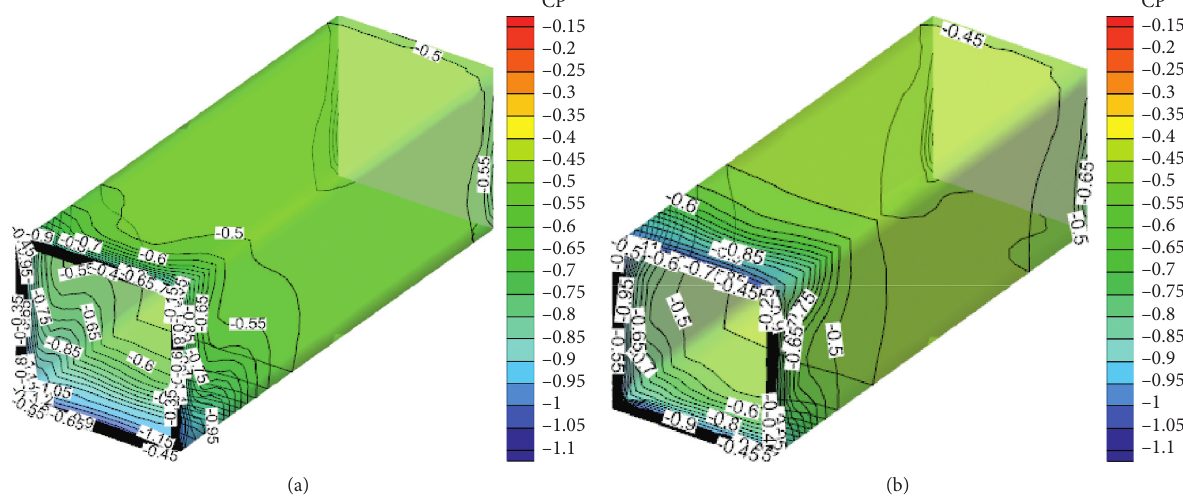
Figure 5: Mean wind pressure distribution in the openings of L-2 model. (a) Upper opening. (b) Lower opening.